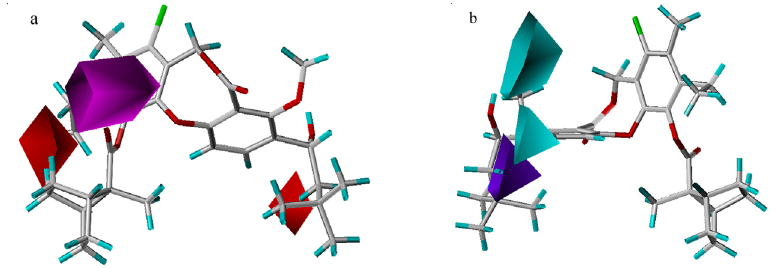
Figure 4. Hydrogen bond acceptor (a) and donor (b) contour maps from the CoMSIA model. Compound 55 is shown inside two fields. The magenta map (contour level 0.03) and two red maps (contour level – 0.015) denote favorable and unfavorable regions for hydrogen bond acceptor groups, respectively. Isopleths in cyan (contour level 0.005), and purple (contour level –0.03) represent favorable and unfavorable areas for hydrogen bond donor groups,